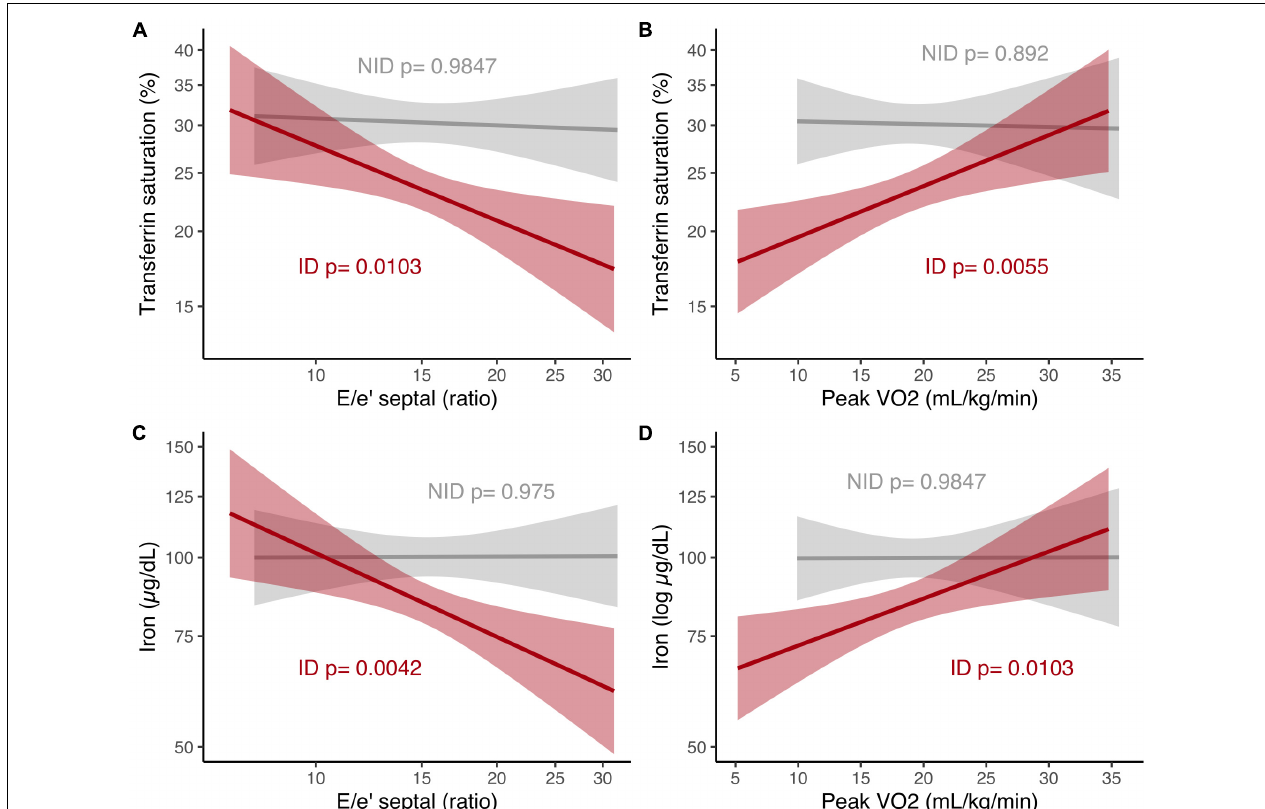
FIGURE 1 | Relationship of iron parameters to E/e (cid:48) septal ratio and peak ˙VO 2 in patients with HFpEF, stratified according to iron status. (A) Transferrin saturation and E/e (cid:48) septal ratio, both log scale. (B) Transferrin saturation (log scale) and peak ˙VO 2 . (C) Iron and E/e (cid:48) septal ratio, both log scale. (D) Iron (log scale) and peak ˙VO 2 . P -values from linear regression analyses in patients with ID and without ID. ID, iron deficiency; NID, no iron deficiency; peak ˙VO 2 , peak oxygen